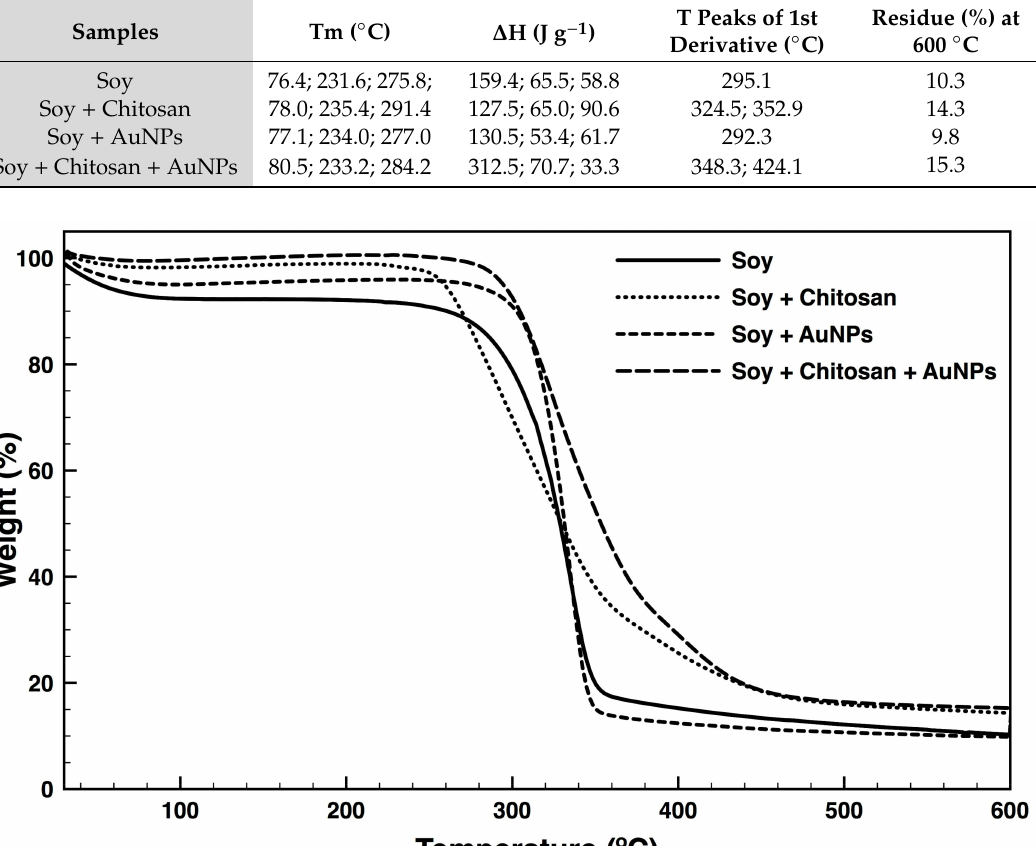
Figure 6. Thermal Gravimetric Analysis (TGA) of soybean fabrics bare and coated with chitosan and / or AuNPs from 30 to 600 ◦ C, performed at a heating rate of 20 ◦ C min − 1 in a nitrogen